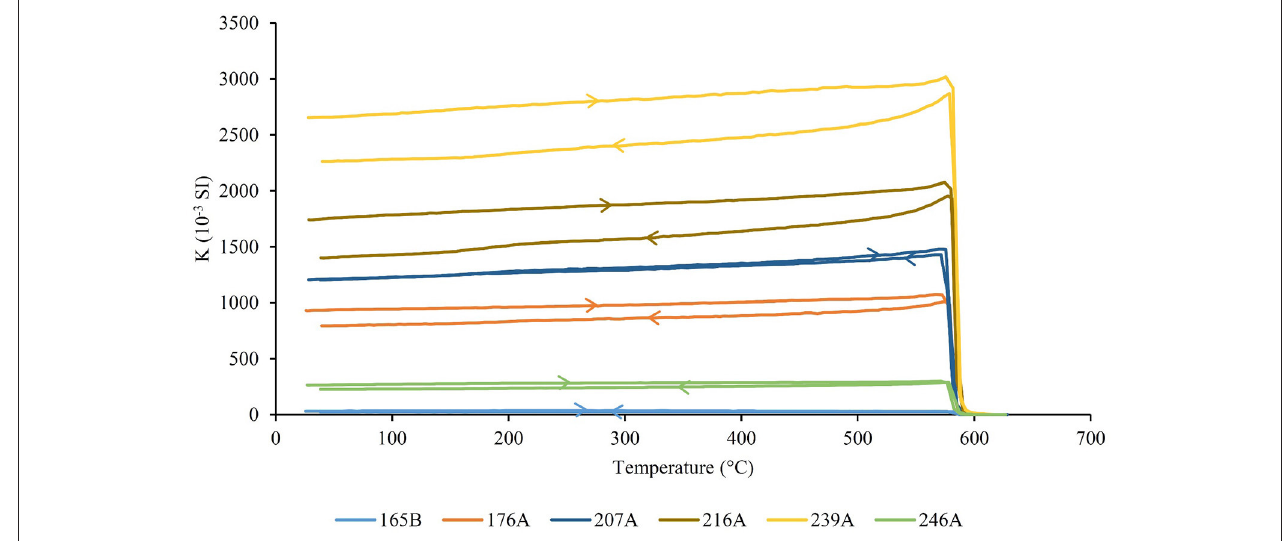
FIGURE 4 | Examples of K-T curves obtained for our BIF samples. The curves selected here span the entire variety of our samples susceptibility values.